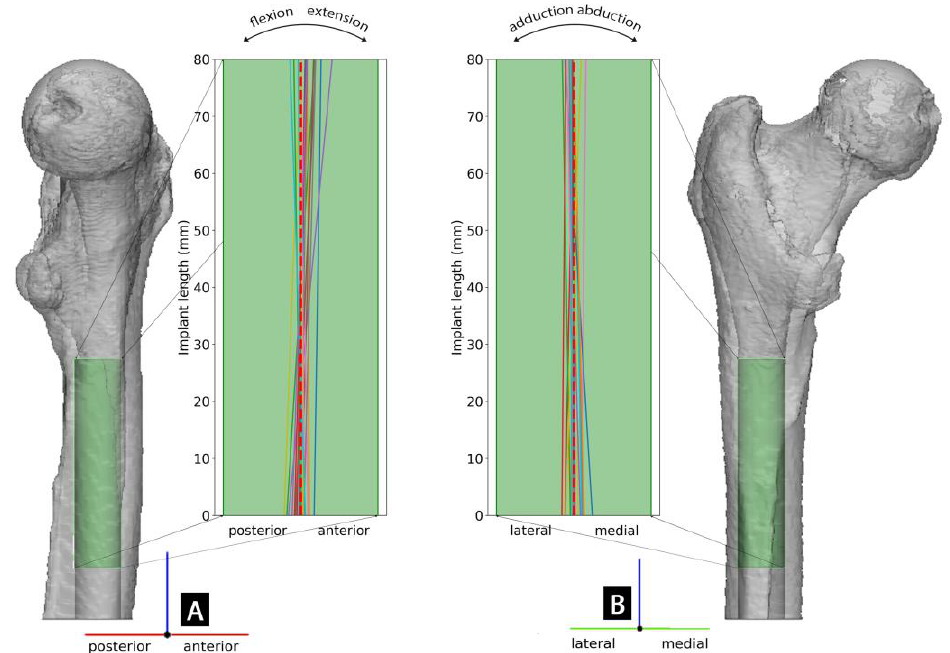
Figure 4. Visualization of the preoperatively planned fixture position (in a left femur) represented by the green cylinder in the 3D model and deviations of operatively achieved final fixture axis for each specimen in the corresponding 18.0 × 80 mm fixture projection in ( A ) lateral and ( B ) anterior-posterior view. The dashed red line represents the preoperatively defined fixture axis. Table 3. Results of correlation analyses of interest, presented as the Pearson product – moment cor- relation coefficient with the corresponding p -value. Statistically significant correlations were high- lighted with an asterisk (*).